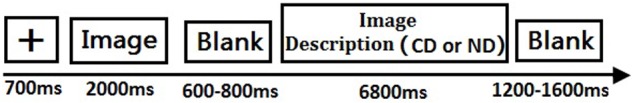
Illustration of an experimental trial.